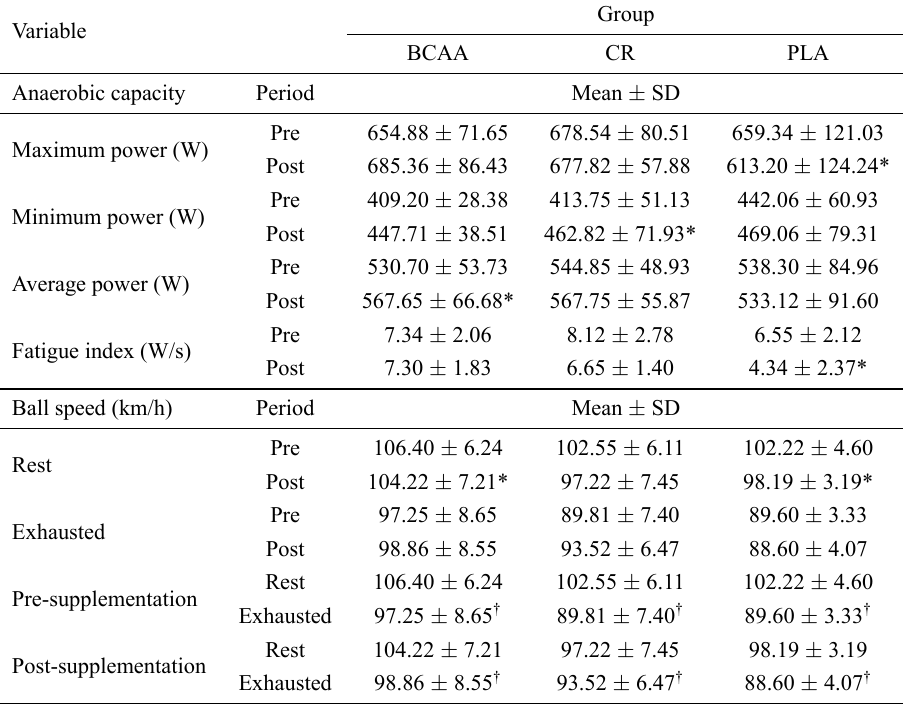
Table 2. Changes in mean values of BCAA, CR, and PLA